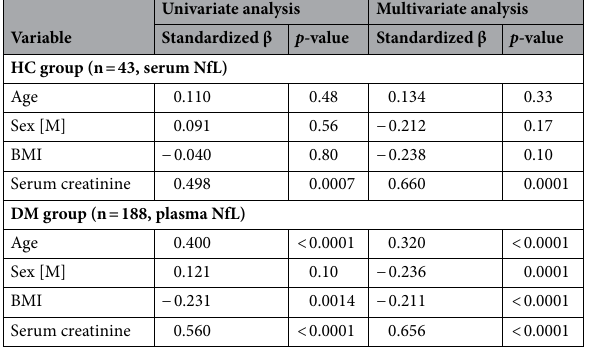
Table 2. Univariate and multivariate linear regression analyses of blood NfL level and age, sex, BMI and serum creatinine. See also supplementary Figs. 1 and 2. BMI body mass index; NfL neurofilament light chain.